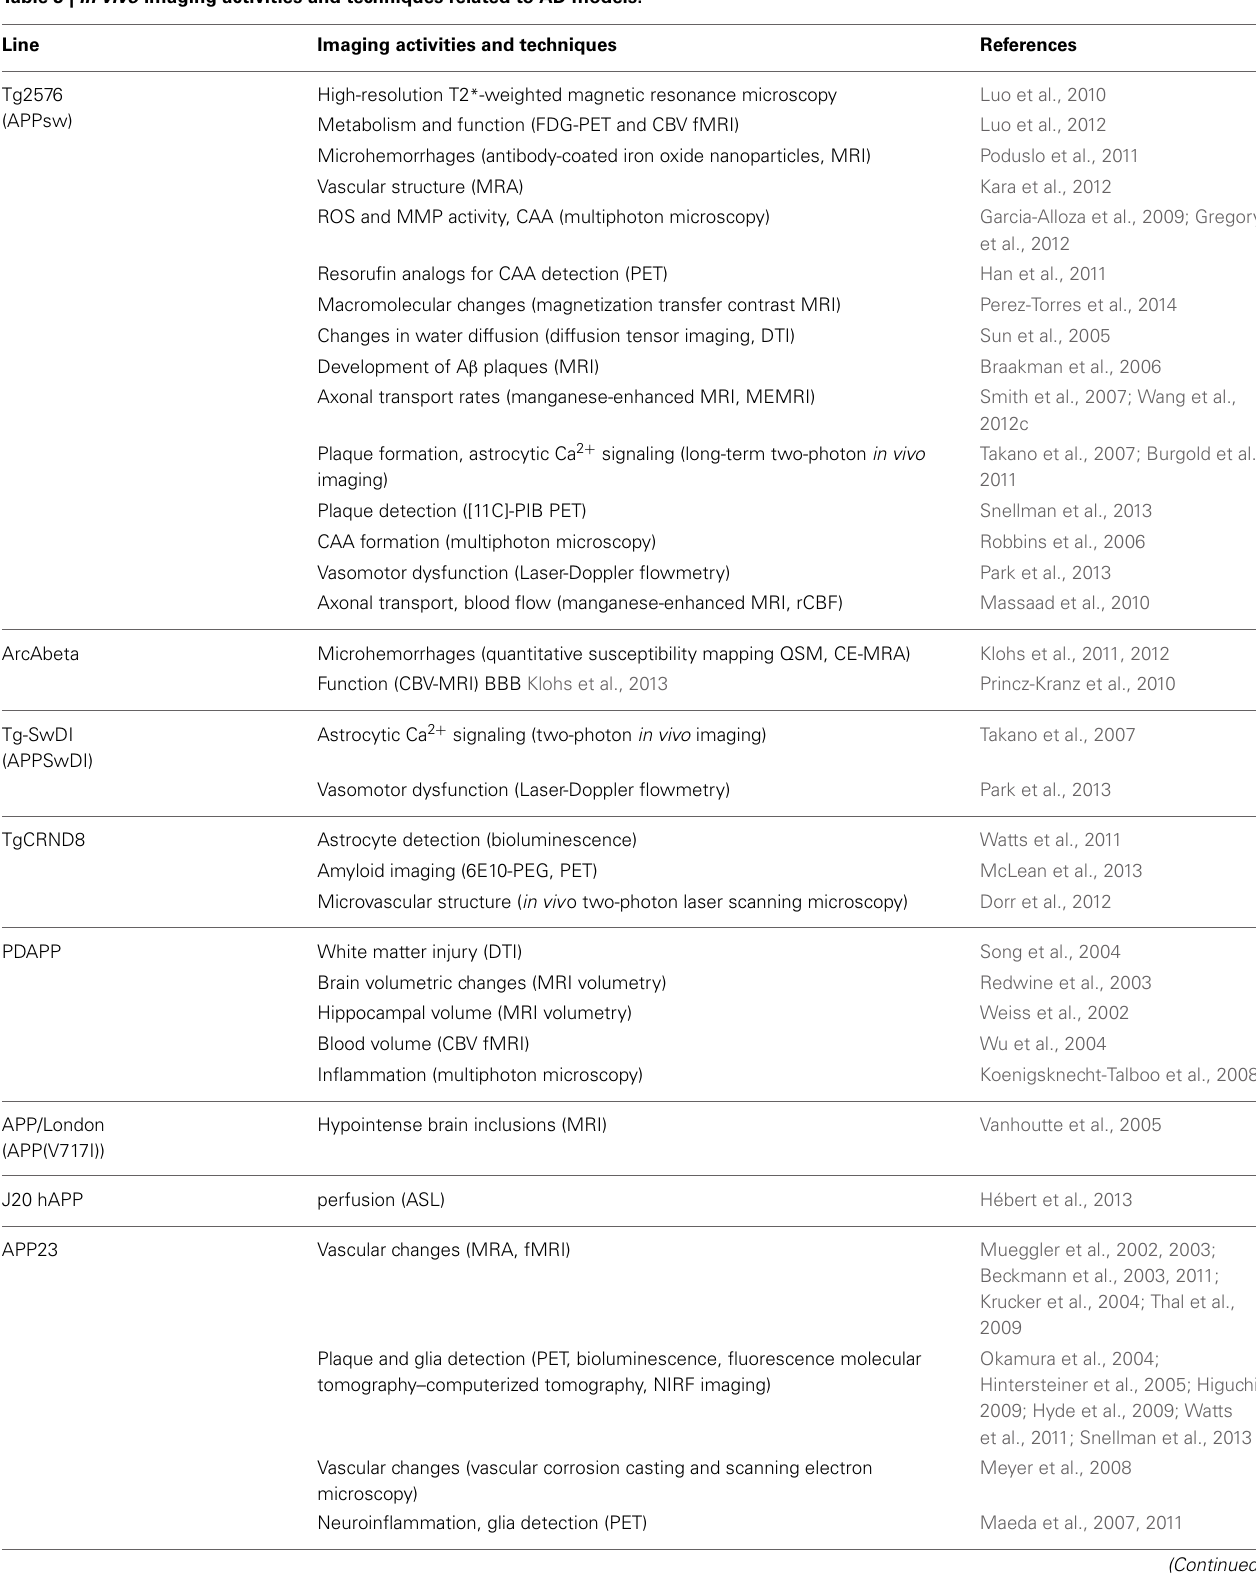
Table 3 | In vivo imaging activities and techniques related to AD